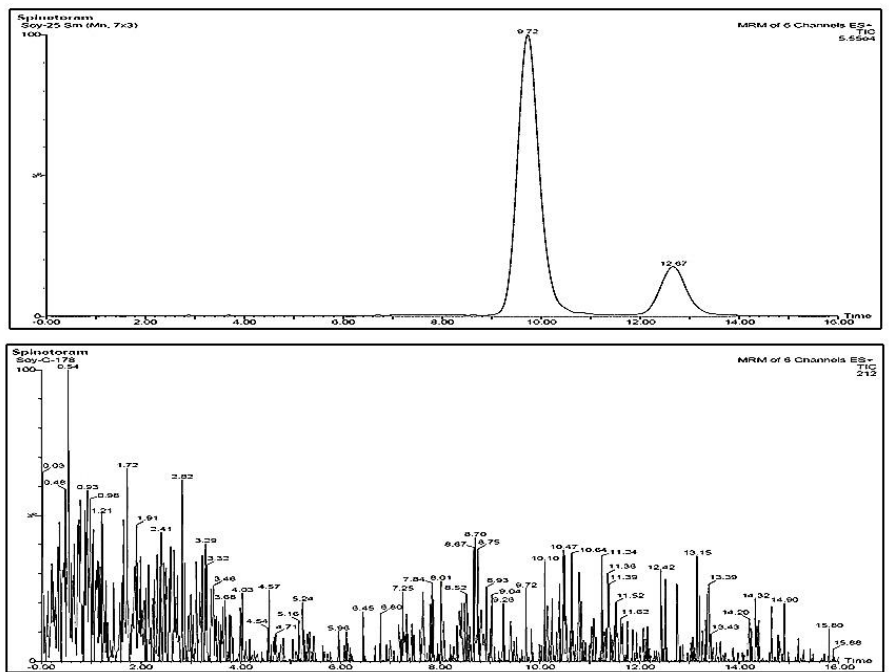
Figure 5. LC ‐ MS/MS chromatogram of spinetoram recovered from soybean when spiked at 25 ng g − 1 ( above ) and chromatogram of control soybean sample ( below ).